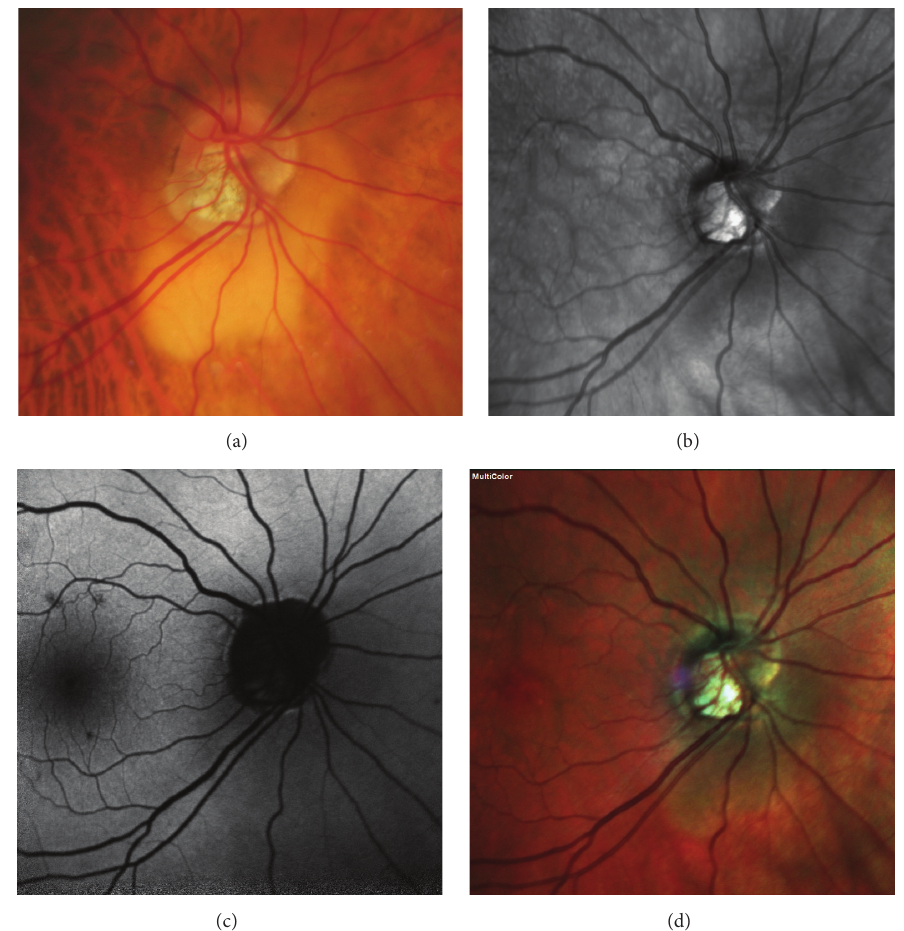
Figure 1: Peripapillary intrachoroidal thickness and cavitation. Color fundus photograph (a), infrared imaging (b), autofluorescence imaging (c),andmulticolorfunduspicture(d)showingawell-circumscribedenlargementoftheyellow-orangeperipapillaryarea,attheinferiorborder of the myopic